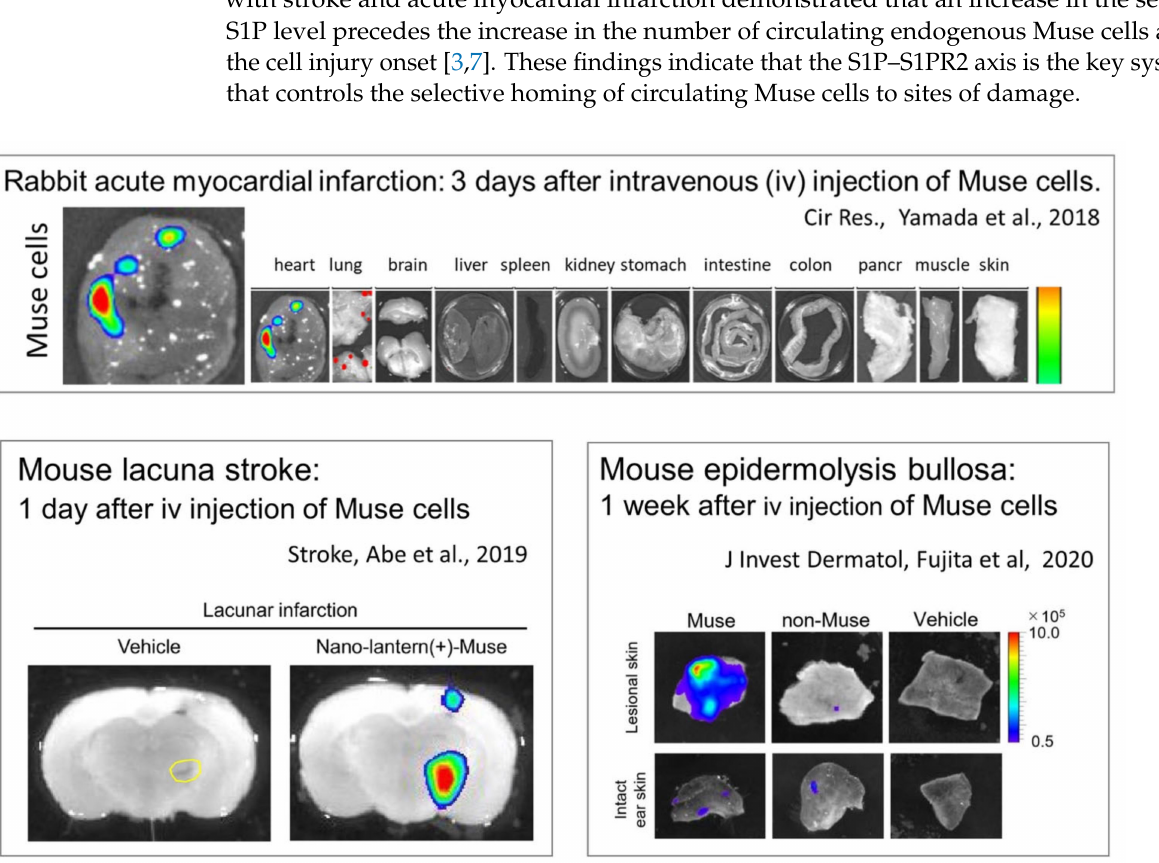
Figure 6. In vivo dynamics of intravenously injected exogenous Muse cells in animal models. Nano-lantern-labeled human Muse cells were intravenously injected into a rabbit model of acute myocardial infarction (3 days after), a mouse model of lacunar infarction (1 day after), and a mouse model of epidermolysis bullosa (1 week after). Muse cells selectively accumulated in the damaged tissue in all